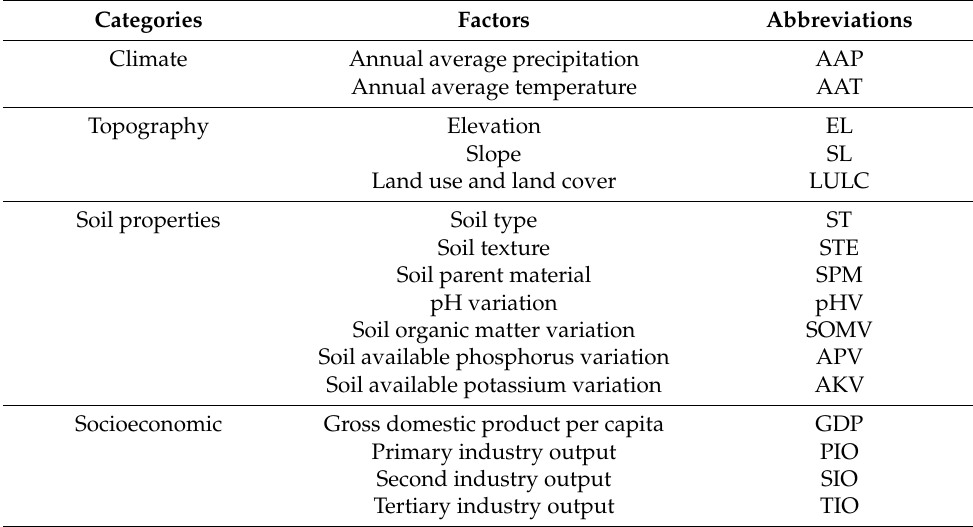
Table 1. Factors used to assess the impacts on cultivated land quality